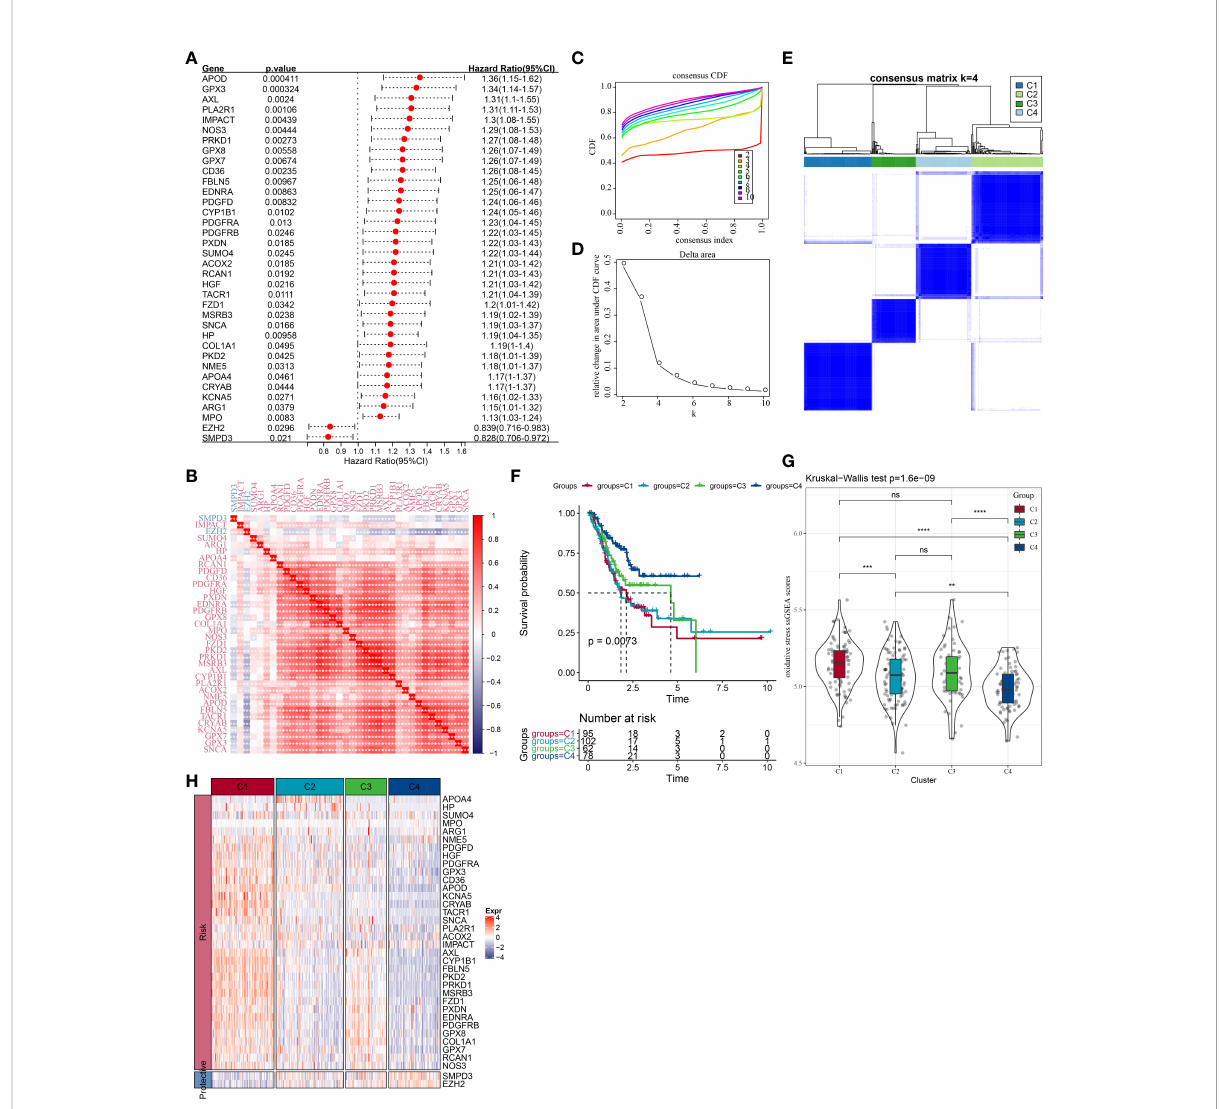
FIGURE 2 Molecular clustering based on OSRGs in the TCGA cohort. (A) Forest plot of OSRGs that correlated with prognosis; (B) Correlation matric of prognosis-related OSRGs; (C) Consensus cumulative distribution function (CDF) diagram when different k values. (D) Delta area plot for relative change in the area under CDF curve for k compared to k-1. (E) Consensus matrix when number of groups (k) = 3. In the consensus matrix, white meant that samples were impossibly clustered together, and dark blue meant that samples were always clustered together. Both rows and columns of the matrix represented samples. (F) Kaplan-Meier curves for overall survival of four molecular subtypes (number of C1 = 95, C2 = 102, C3 = 62, and C4 = 78). The survival probabilities were compared with log-rank test. (G) Comparison of OS ssGSEA score among the C1, C2, C3, and C4 subtypes in the TCGA cohort. (H) Clustering analysis of the expression of the 36 prognostic OSRGs. ns, no signi fi cance. * P < 0.05, ** P < 0.01, *** P < 0.001, **** P <